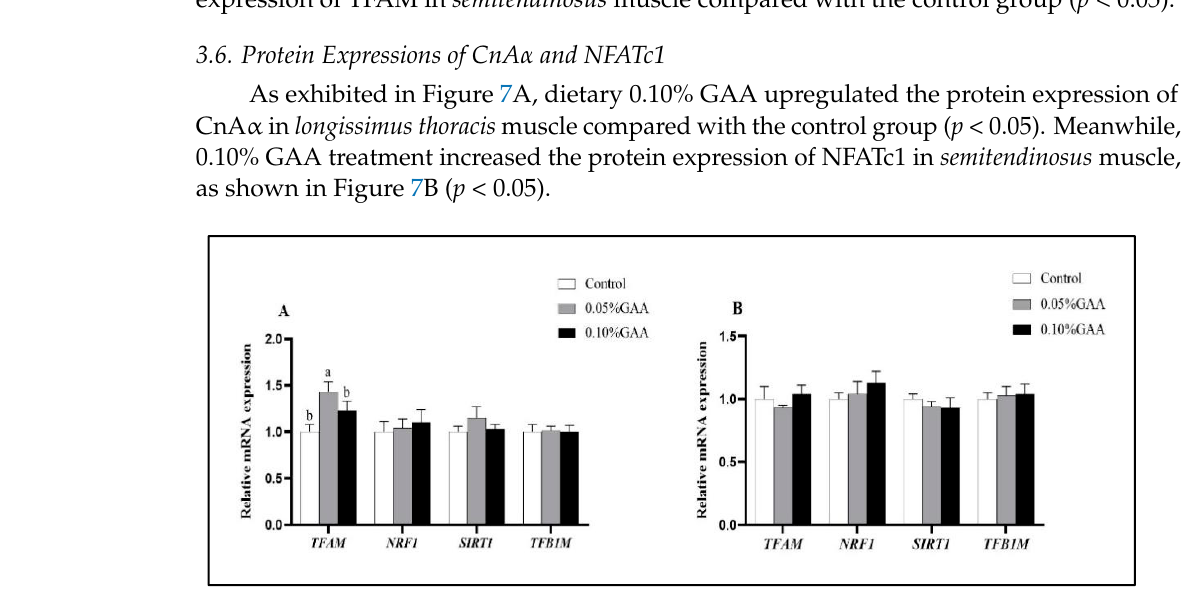
Figure 5. Effects of guanidinoacetic acid supplementation on the related genes of mitochondrial synthesis of ( A ) longissimus thoracis muscle and ( B ) semitendinosus muscle in finishing pigs. Means with different letters differ significantly ( p < 0.05). Values are presented as the mean ± SEM ( n = 5). Control: Finishing pigs were fed a basal diet; 0.05% GAA or 0.10% GAA: Finishing pigs were fed a